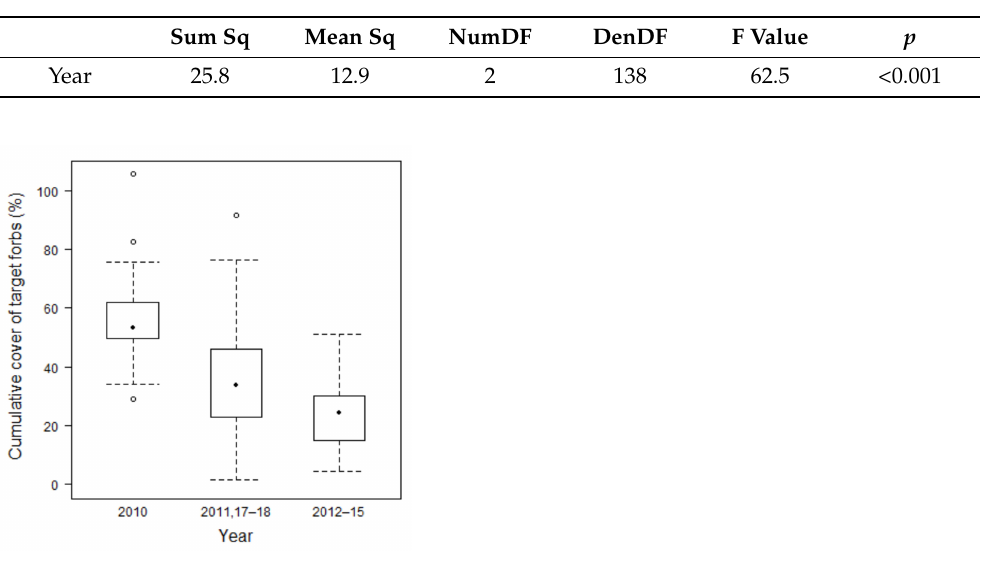
Table A3. Effects of year on the cumulative cover of target forbs according to the minimal adequate model. The model had three levels for year (Figure A4).